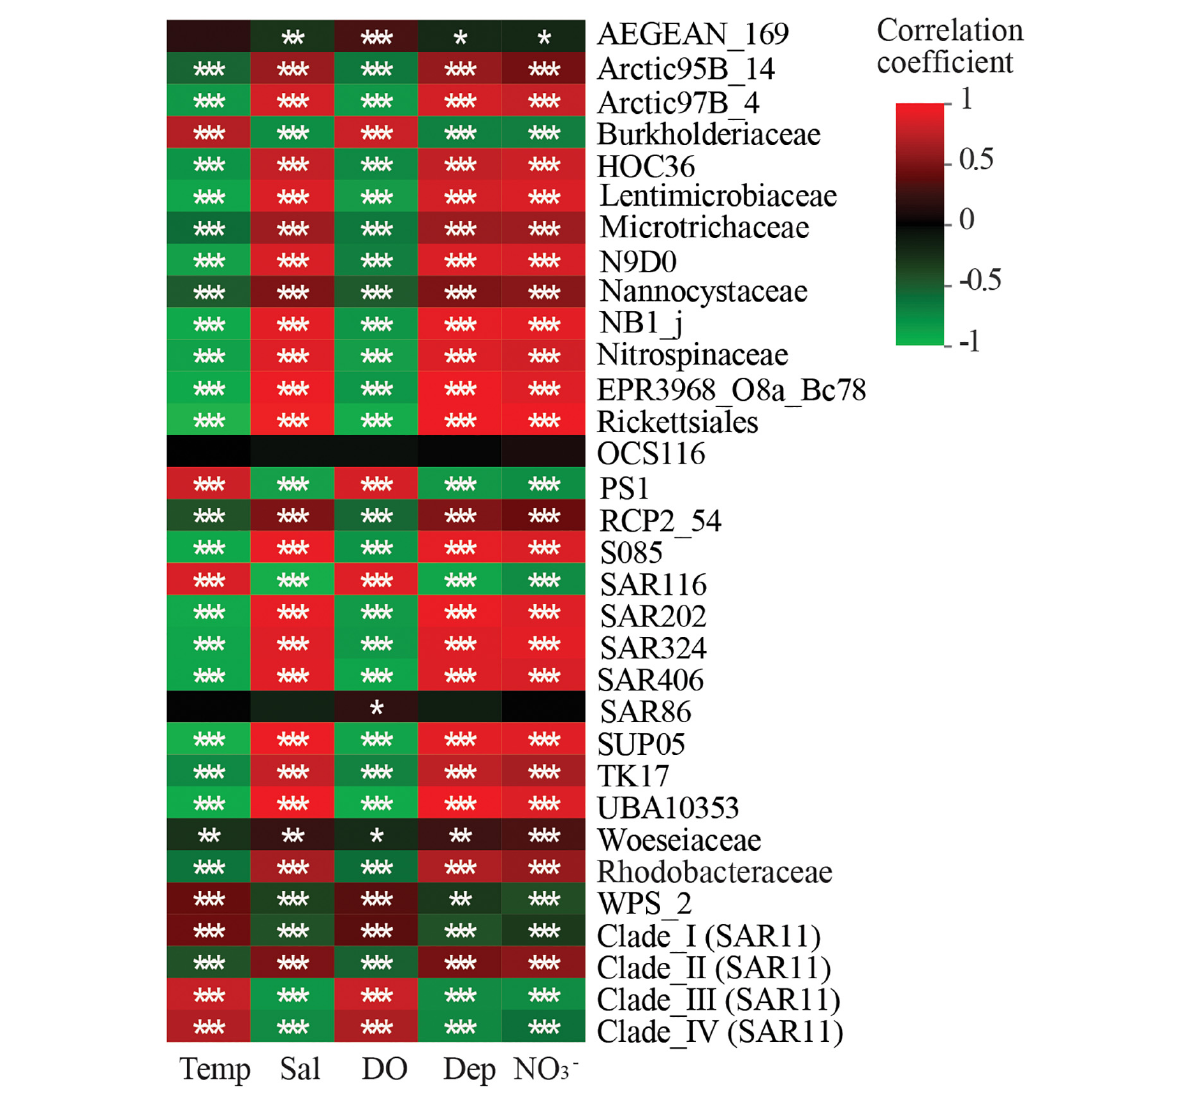
FIGURE7 Heatmap showing the correlations of biomarker and keystone taxa with environmental factors. Temp, temperature; Sal, salinity; DO, dissolved oxygen; Dep, depth; NO 3 − , Spearman’s correlation analysis was employed in the correlation analysis of environmental factors and each taxon. Correlation coefficient value R were shown in different colors. ∗ p < 0.05; ∗∗ p < 0.01; ∗∗∗ p <